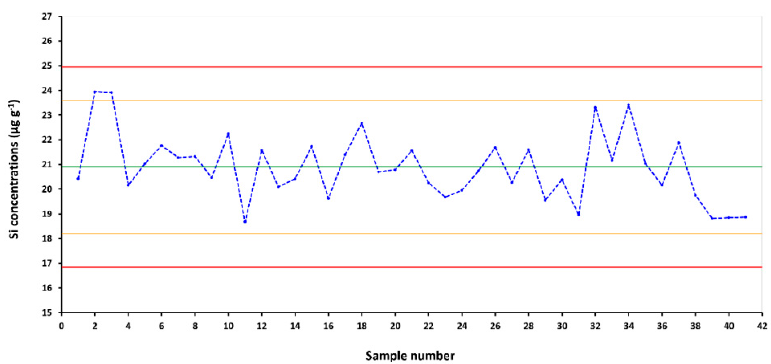
Figure 4. Control chart obtained over 6 months of measures for quality control material (QCM) by ICP-DRC-MS.